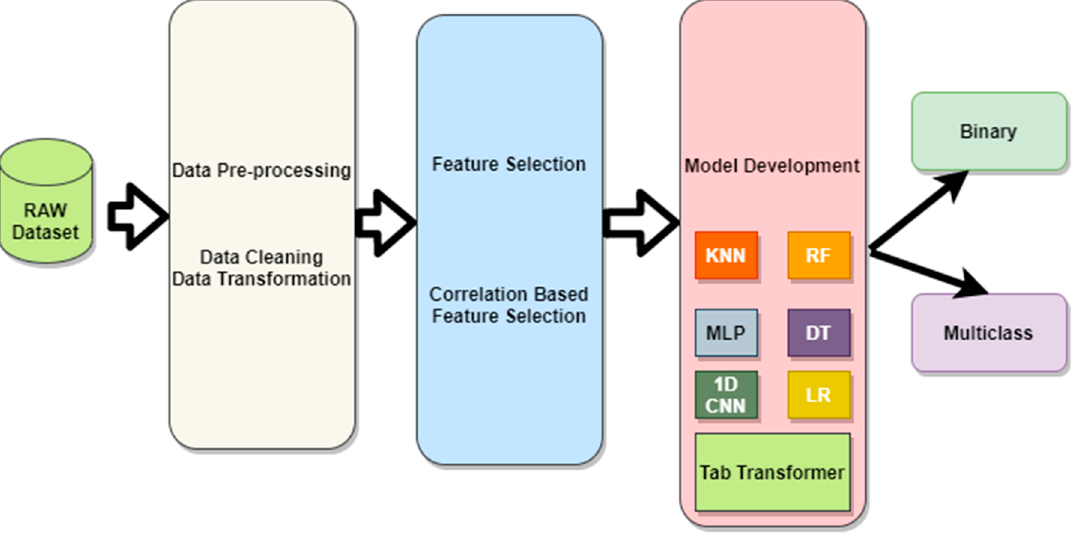
Figure 4. Proposed framework for detecting anomalies from IoT networks.